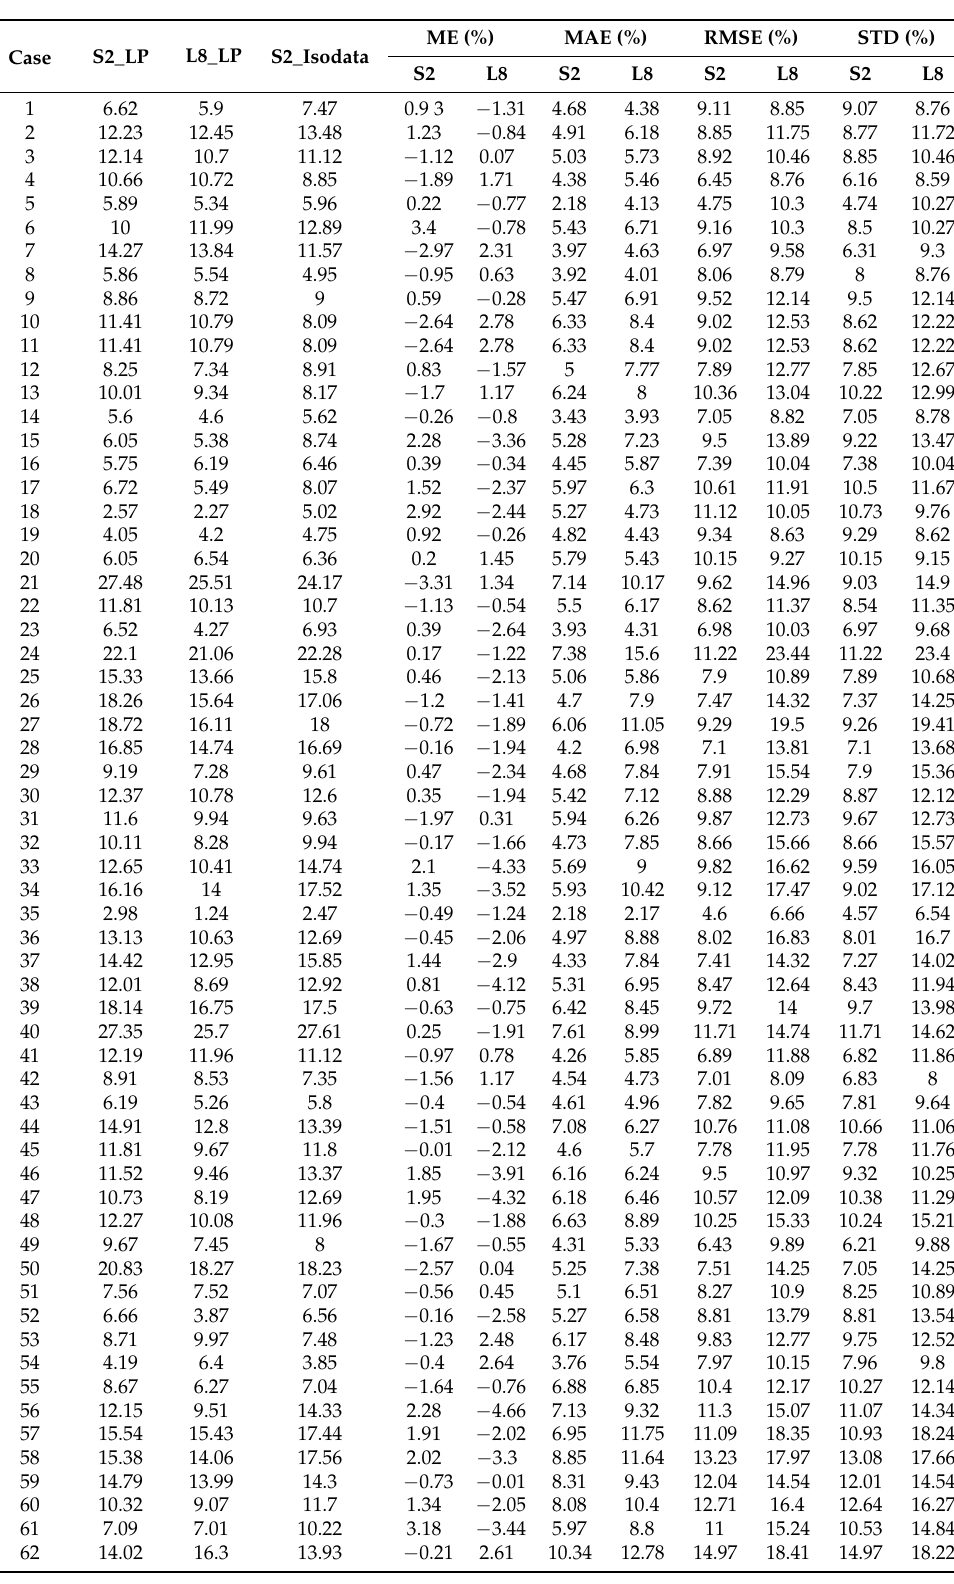
Table A2. The error of average MPF for the 80 cases of LinearPolar algorithm on S2 and L8 data and ISODATA method on